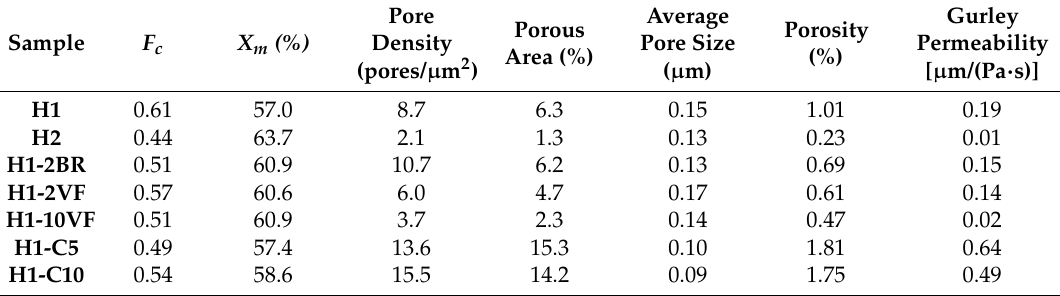
Table 2. Polymer composition analysis, in terms of orientation of precursor films and membrane crystallinity, membrane pore morphology and membrane